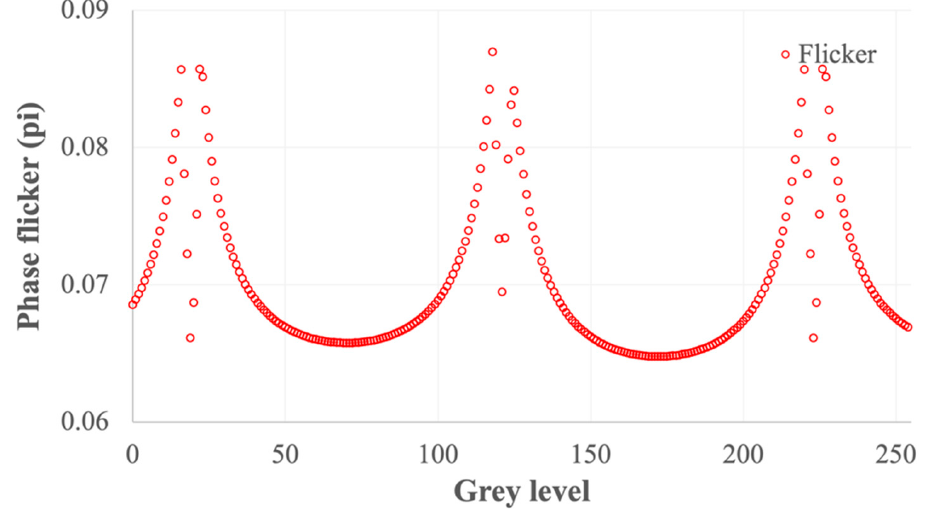
Figure 11. Calculated phase flicker at each phase level with an additional quarter waveplate.